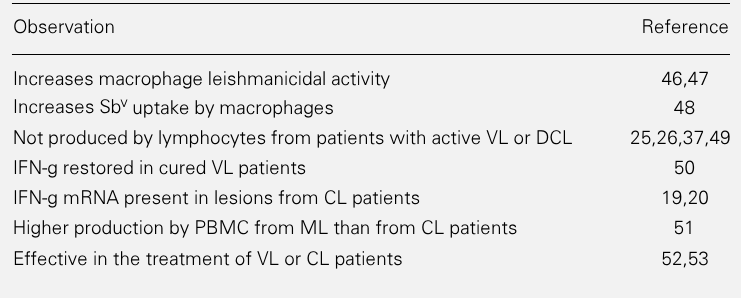
Table 1 - Interferon-g in human leishmaniasis.